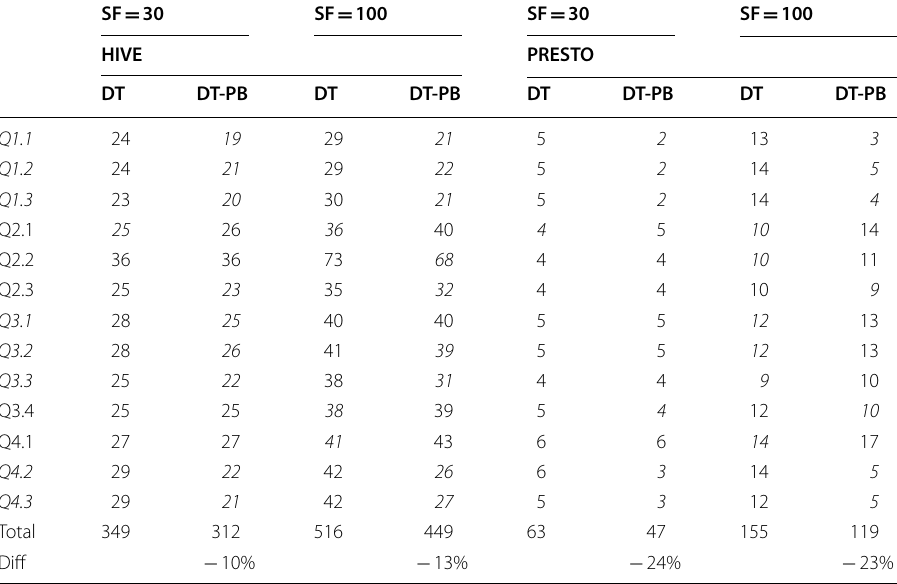
Table 12 SSB execution times (in seconds): partitioning by “Od_Year” and